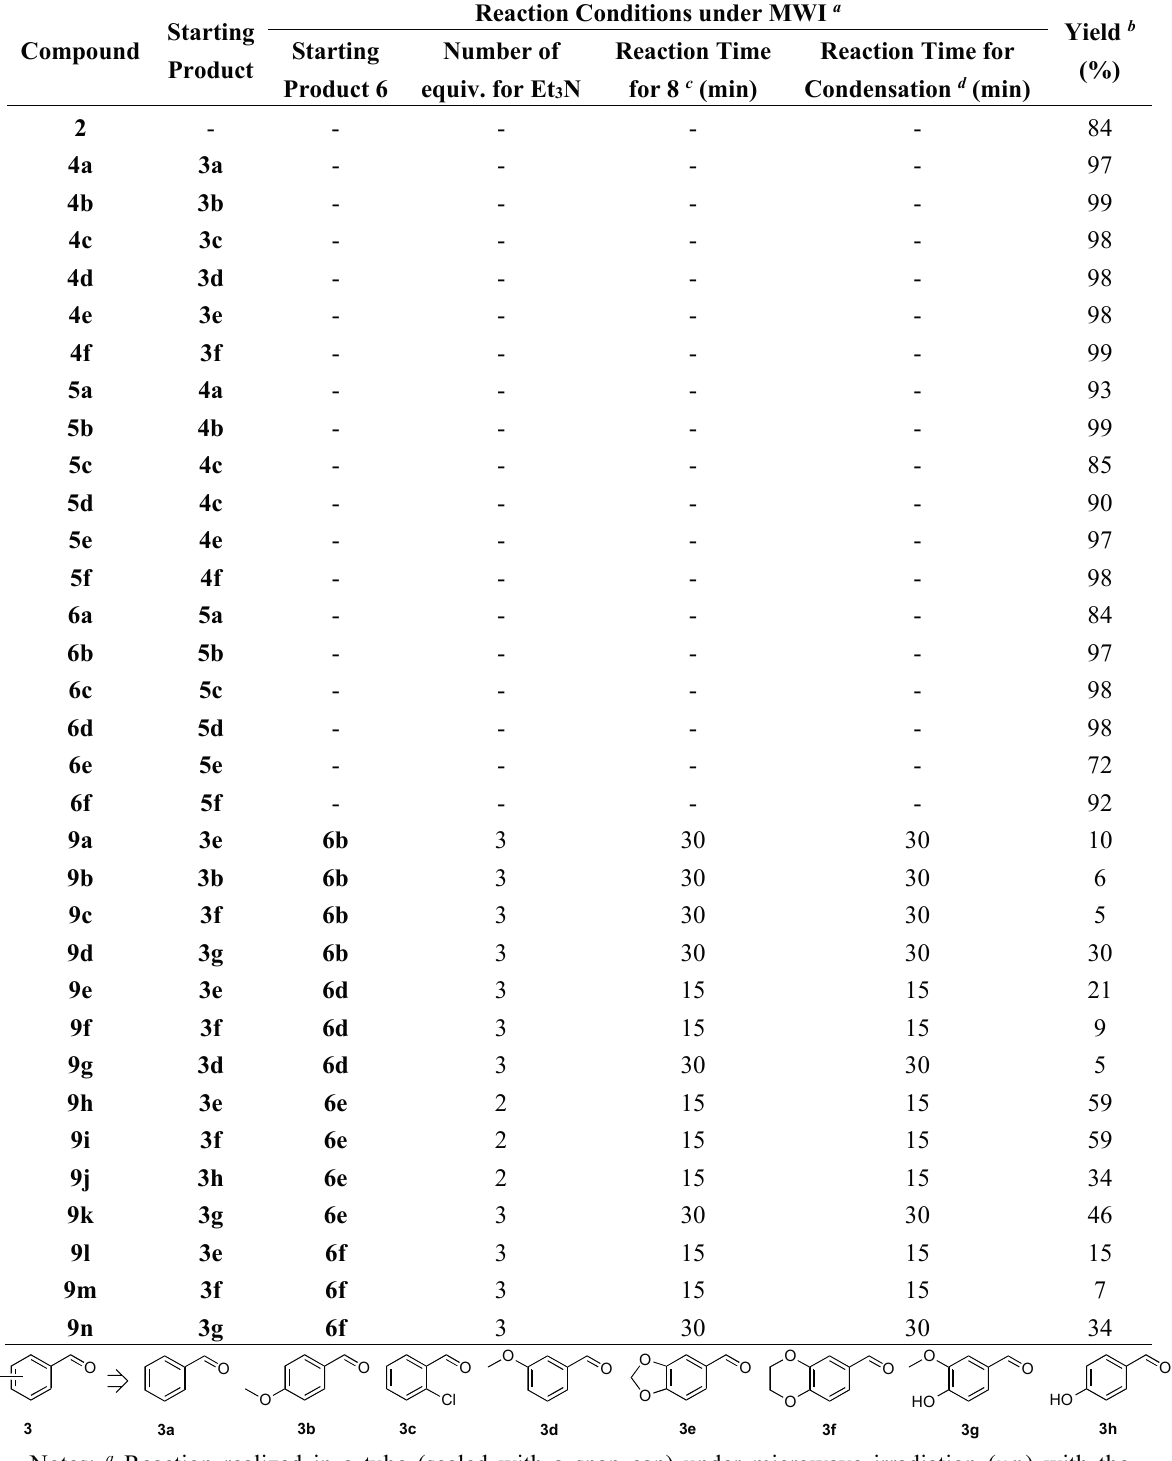
Table 1. Results for the preparation of compounds 2 , 4 , 5 , 6 and 9 .